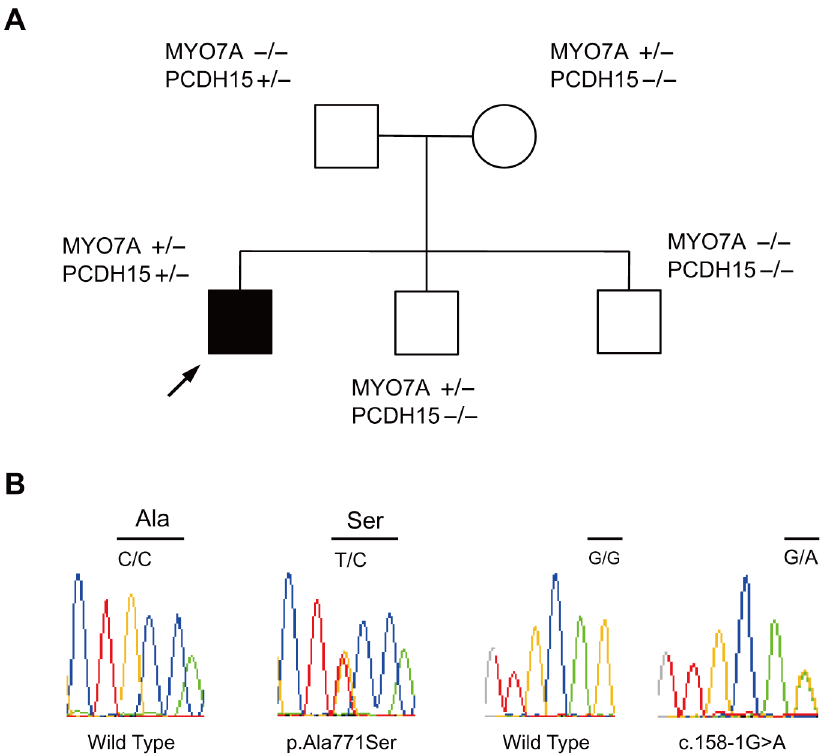
Figure 2. Pedigree and sequence chromatograms of the patient with the p.Ala771Ser in MYO7A and c.158-1G . A in PCDH15 mutations. (A) The pedigree and sequence results of the proband and family. (B) Sequence chromatograms from wild-type and mutations. The proband, his mothor and one brother carried a heterozygous 2311G . T transition in exon 20, which results in an alanine to a serine (Ala771Ser) in MYO7A . Another variation, 158-1G . A in intron 3 of PCDH15 , was derived from the proband and his father. Another brother had no variants.